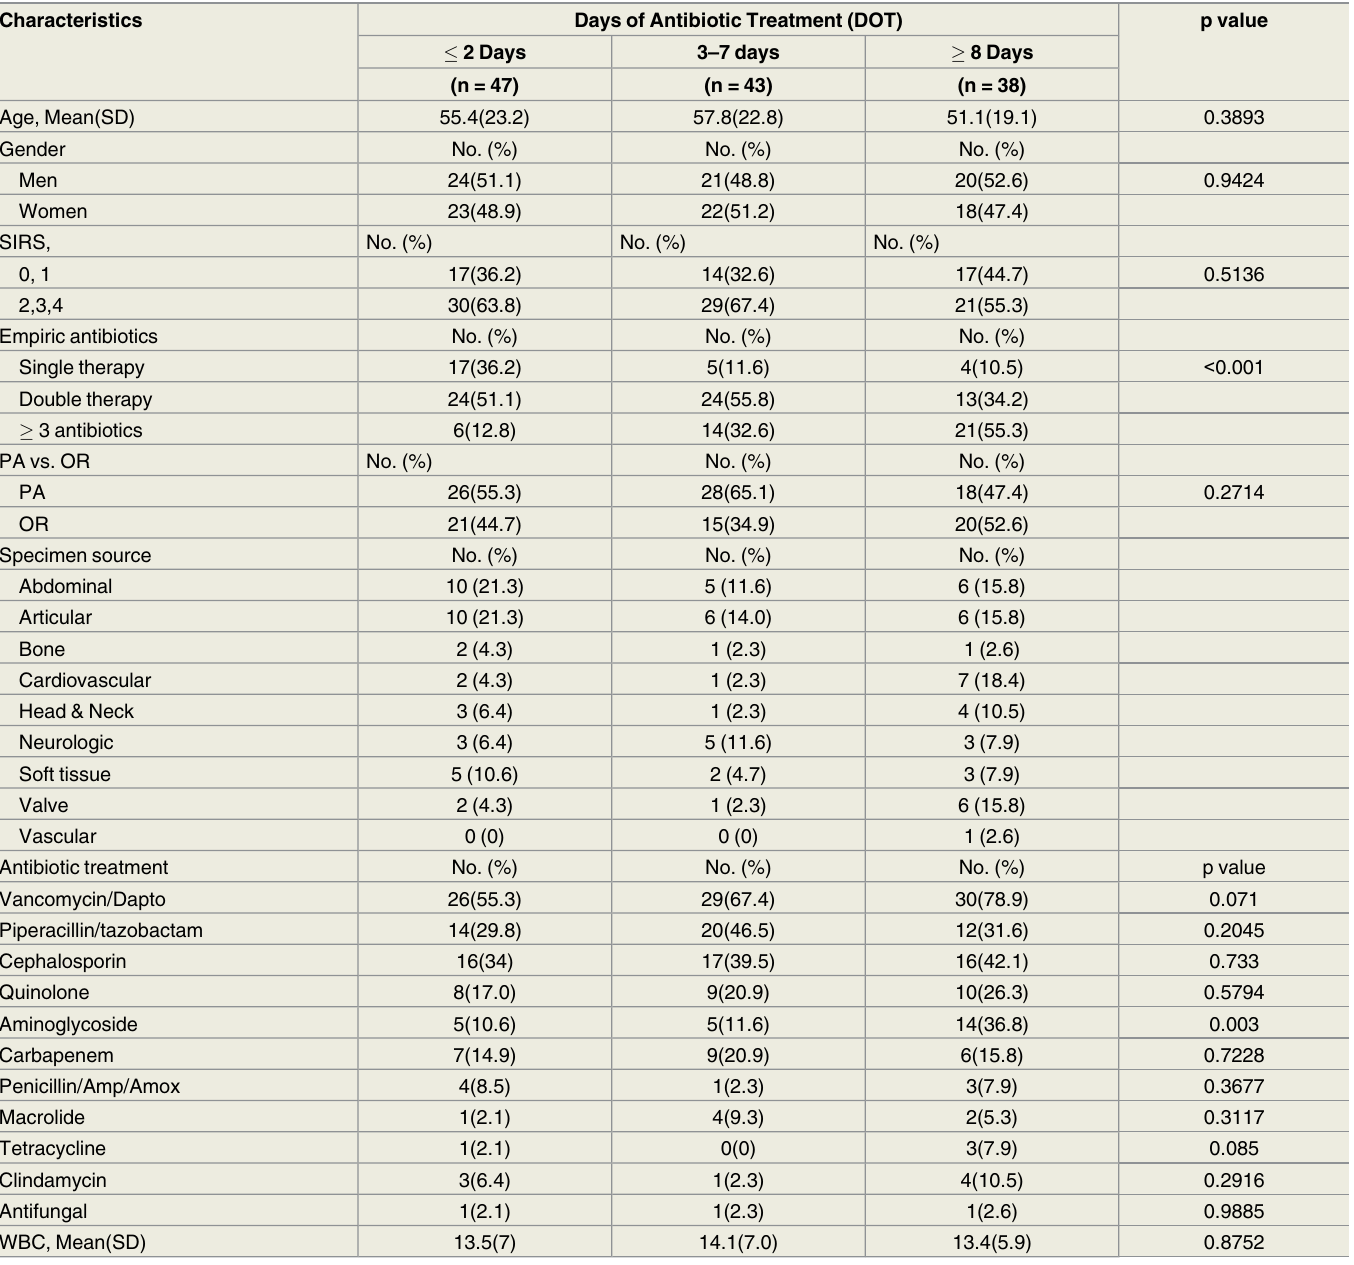
Table 1. Demographic, specimen source and patient treatment